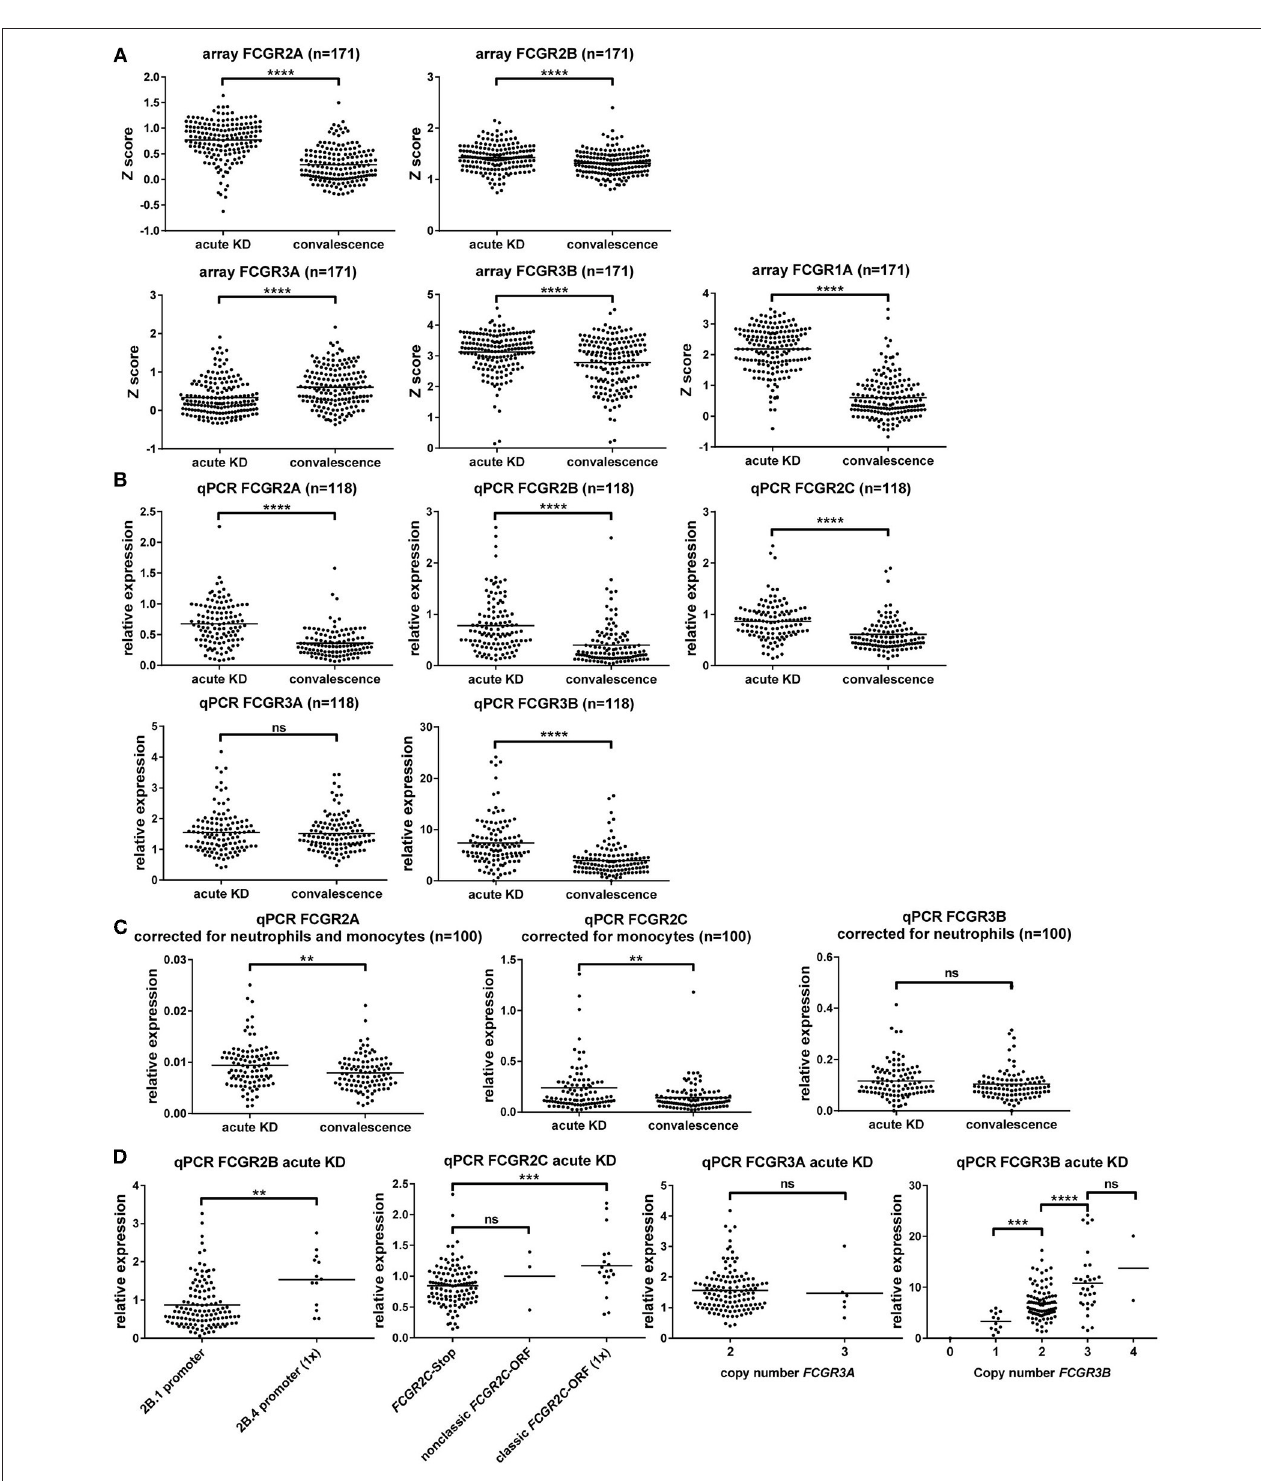
FIGURE 5 | Gene expression analysis of Fc γ Rs shows upregulation of Fc γ RI and Fc γ RII, but not Fc γ RIII during acute KD. (A) Difference in expression intensity of various FCGR transcripts, as determined by RNA microarray, shown as Z scores (higher score indicating higher expression), in 171 subjects with KD in the acute and convalescent phase of the disease. (B–D) Relative expression of different FCGR transcripts detected by qPCR on whole blood, corrected for housekeeping genes GUS and GAPDH, as compared to one randomly chosen sample in the convalescence phase of KD. (B) Dot plots showing a comparison of the acute and convalescent phase of KD in 118 patients. (C) Dot plots showing a comparison of the acute and convalescent phase of KD for transcripts of FCGR2A, FCGR2C,